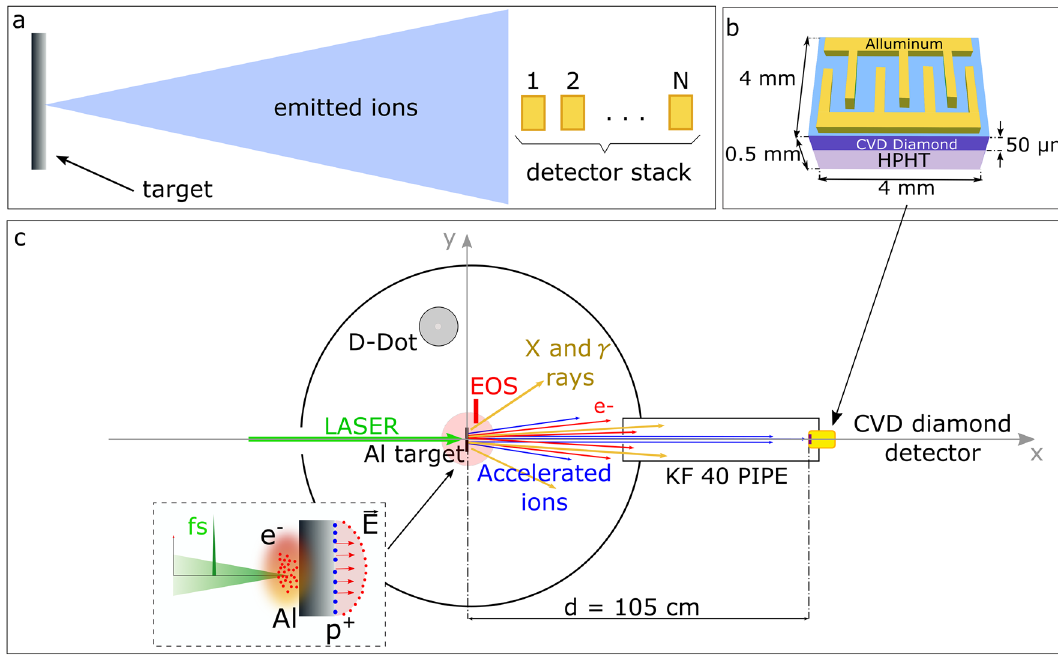
Figure 1. ( a ) Basic scheme of the advanced TOF detector. ( b ) Schematic representation of the diamond detector in planar-interdigital configuration. ( c ) Experimental chamber layout; in the inset: a scheme of the laser-plasma interaction highlighting the TNSA mechanism, being E the electric field generated on the rear side of the target by the escaping hot